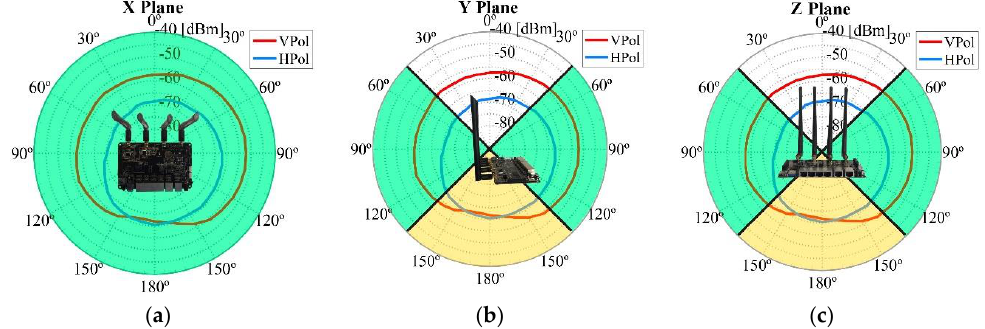
Figure 12 . Example of a measurement of the complete radiation pattern and example of possible areas of interest for each communication link, which are highlighted in green for the U2U link and yellow for the U2G link: ( a ) X Plane, ( b ) Y Plane, and ( c ) Z Plane.